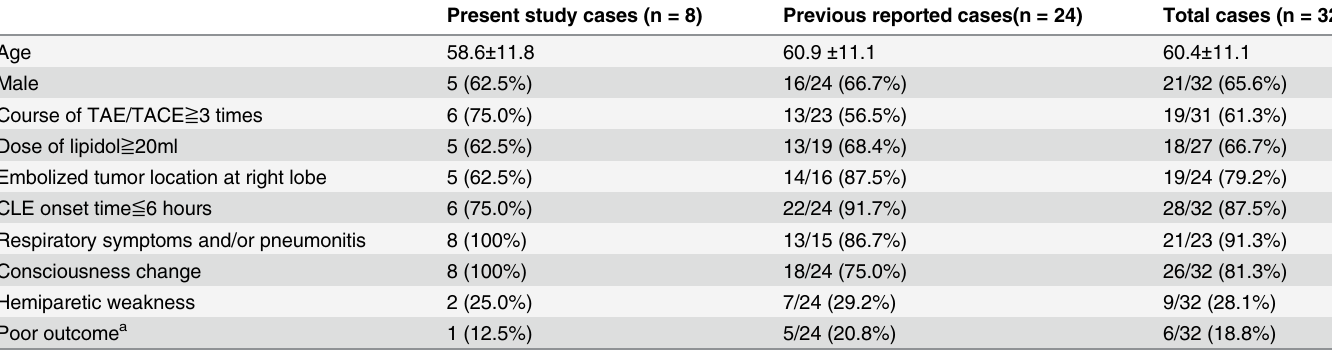
Table 2. Clinical Manifestations of 32 Reported Cases with Cerebral Lipiodol